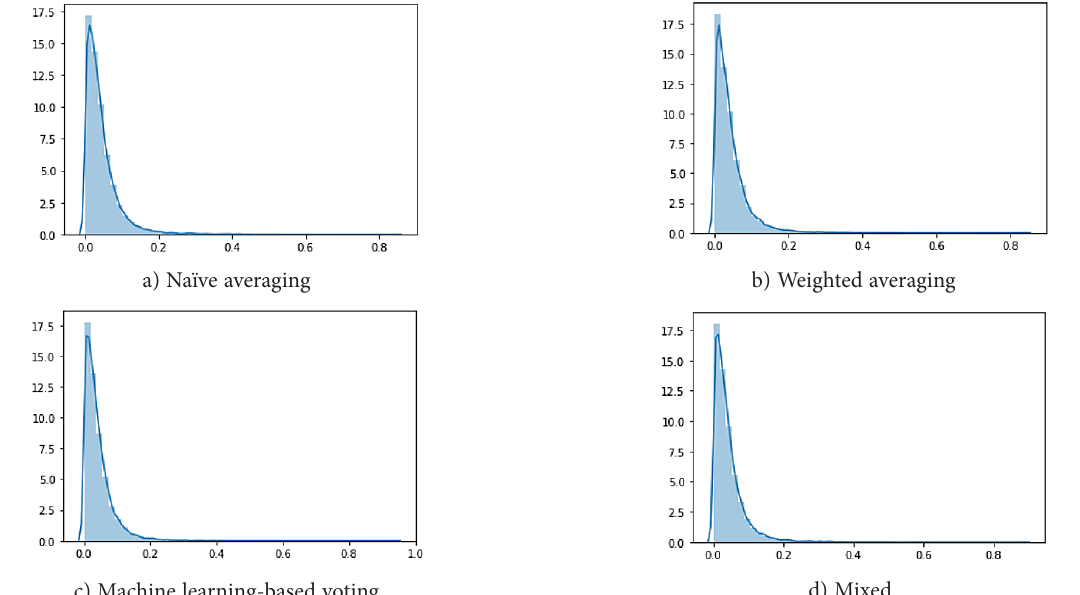
Figure 10. Distribution of prediction errors (combined models)